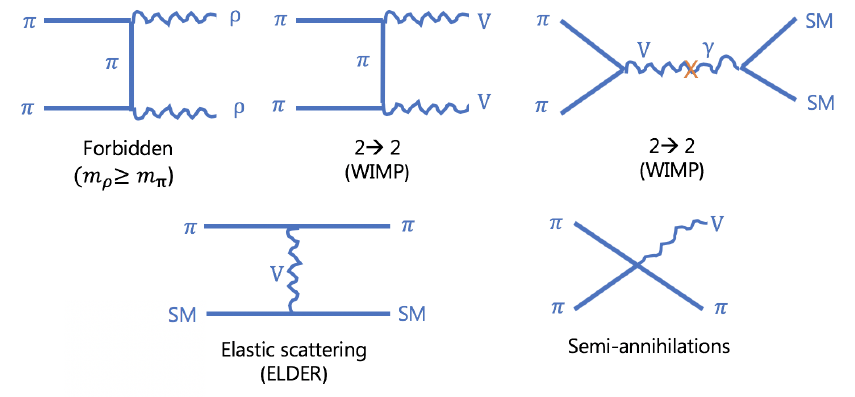
Figure 5: Examples of 2 → 2 processes that can occur in QCD-like dark sectors, with π , ρ indicating dark mesons, and the dark pions are the